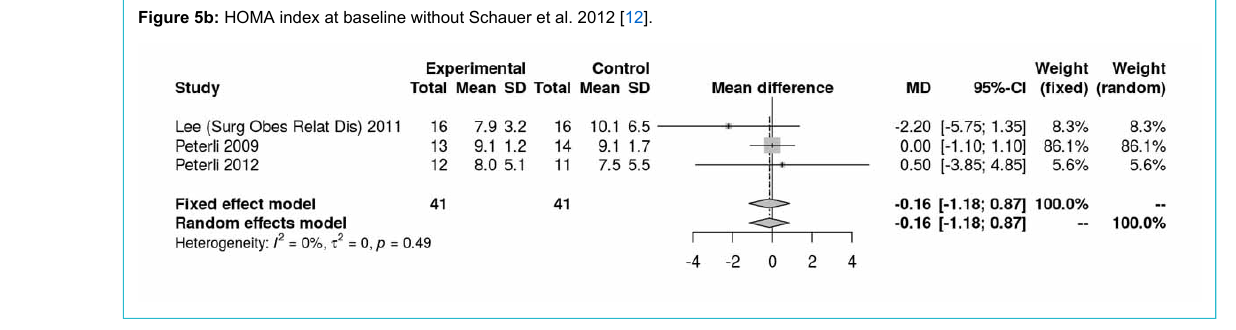
Figure 5b: HOMA index at baseline without Schauer et al. 2012